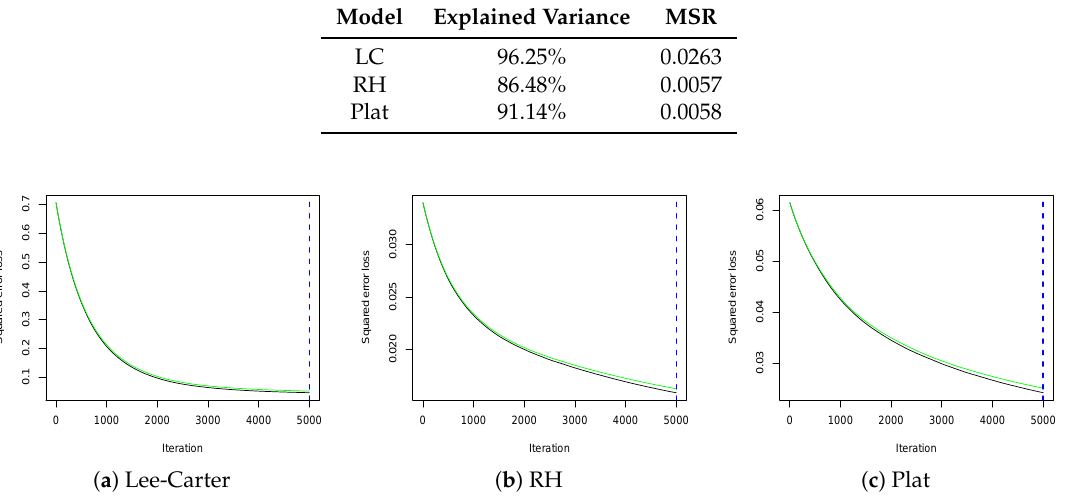
Table 2. Explained variance and MSR by the RF algorithm for the LC, RH, and Plat model. Ages 0–100 and years 1915–2014, Italian population.